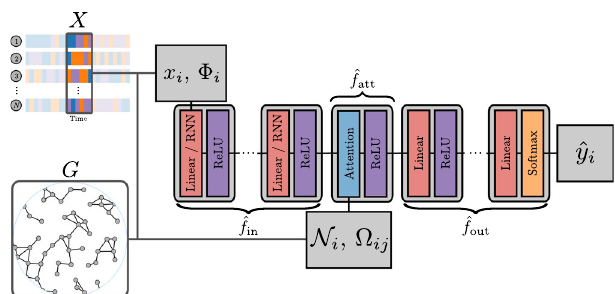
Fig. 6 Visualization of the GNN architecture. The blocks of different colors represent mathematical operations. The red blocks correspond to trainable af fi ne transformation parametrized by weights and biases. The purple blocks represent activation functions between each layer. The core of the model is the attention module 41 , which is represented in blue. The orange block at the end is an activation function that transforms the output into the